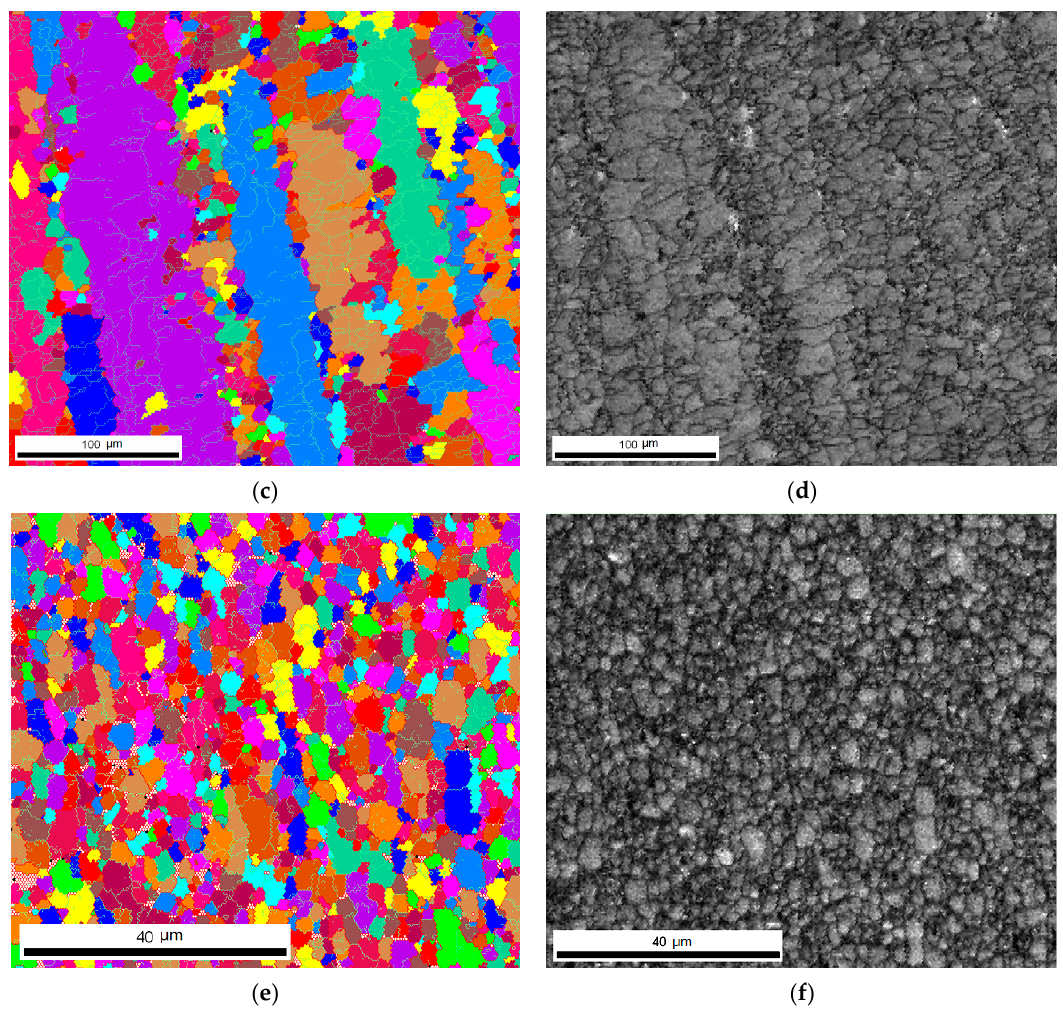
Figure 2. EBSD (Electron Back-scattering Patterns) images for di ff erent characteristic area: ( a ) IPF